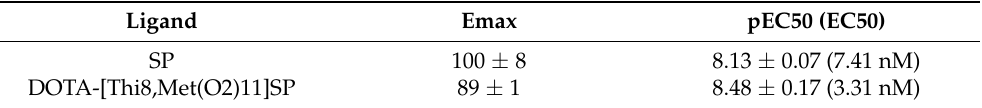
Figure 3. Dose–response analysis of NK1R activation by SP and DOTA-[Thi 8 ,Met(O 2 ) 11 ]SP. HEK293-T cells transfected with NK1R were stimulated with a range of concentrations of SP or DOTA- [Thi 8 ,Met(O 2 ) 11 ]SP and receptor activation was measured using an IP accumulation assay. Data are presented as % of the maximal response elicited by SP and are mean ± SEM ( n = 3). Data were fitted to three-parameter sigmoidal dose–response equations used to calculate values for potency (pEC 50 ) and E max (Table 2). Table 2. Dose–response parameters for stimulation of cells expressing NK1R with SP and DOTA- [Thi 8 ,Met(O 2 ) 11 ]SP.